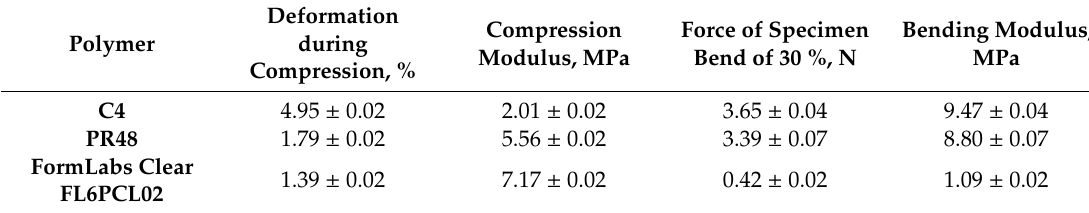
Table 4. Mechanical characteristics of the cross-linked vanillin-based polymers.